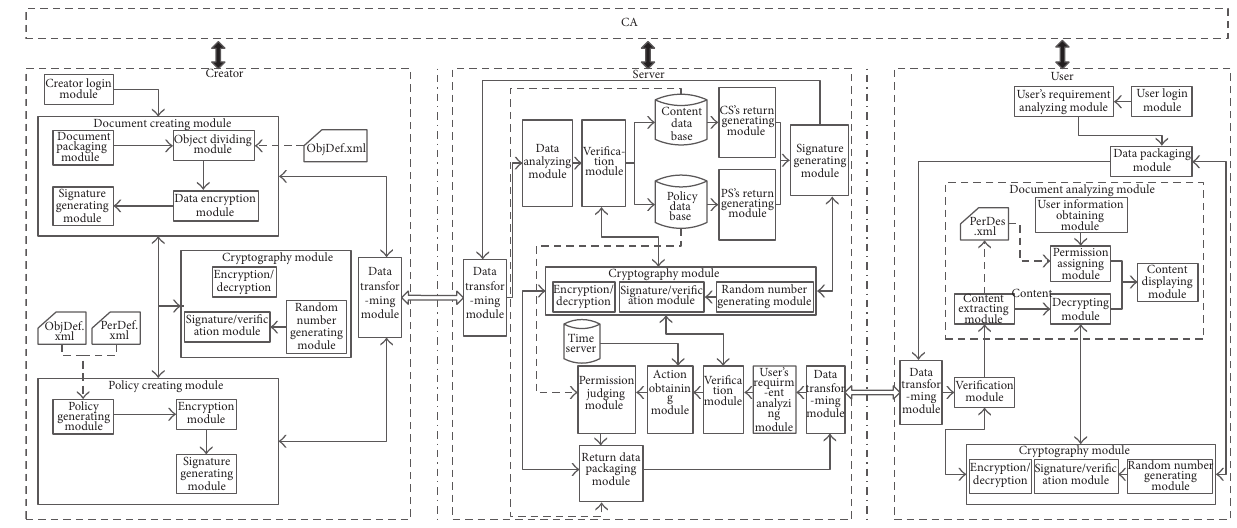
Figure 5: Framework for